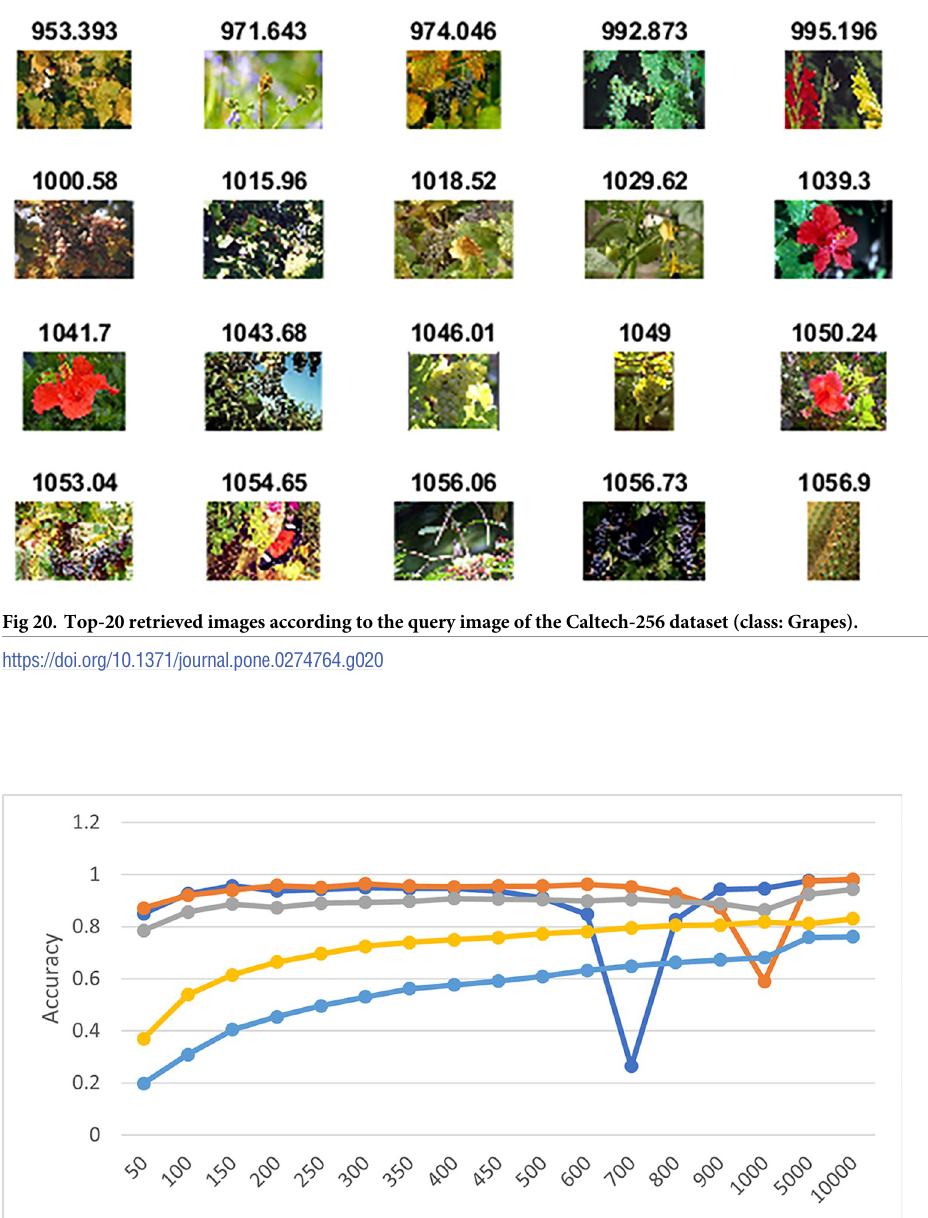
PLOS ONE | https://doi.org/10.1371/journal.pone.0274764 October 3,